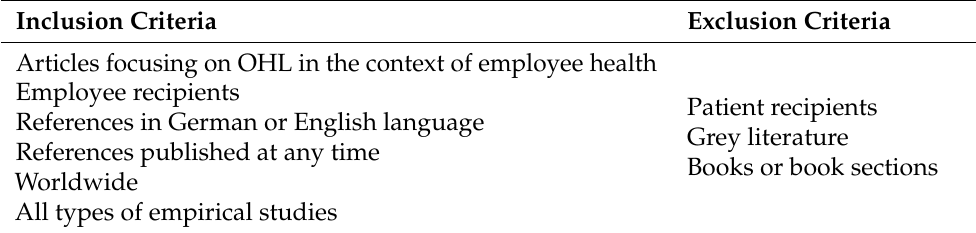
Table 3. Inclusion and exclusion criteria,